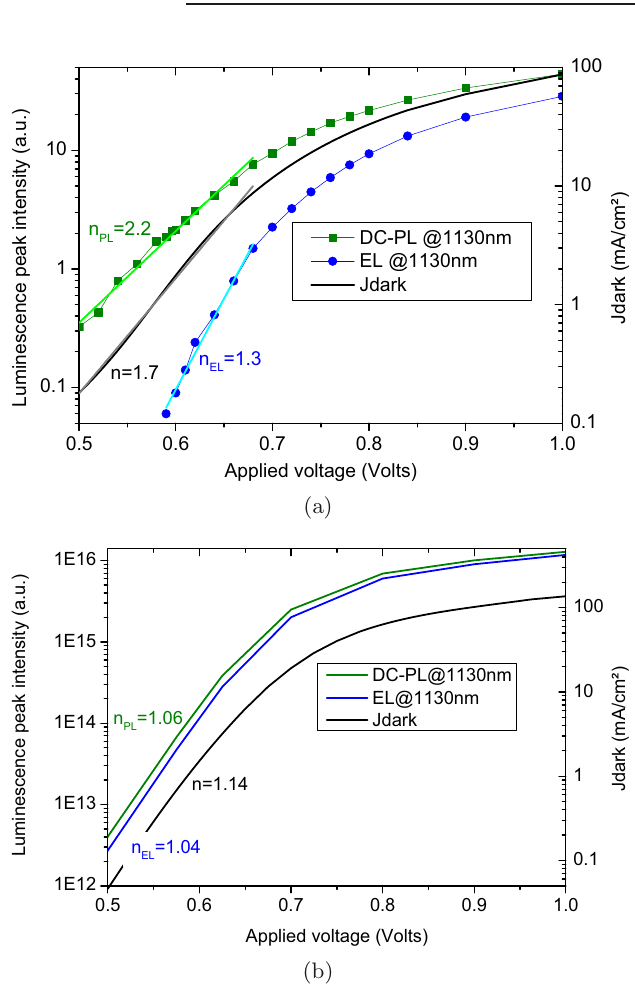
Fig. 4. Variations of (a) measured and (b) model-generated EL and PL peak intensities under DC-bias with respect to the applied voltage. Comparison with (a) the measured and (b) the modelled dark J ( V )